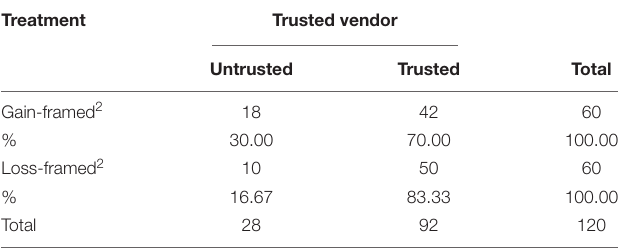
TABLE 6 | Decision 4 – choosing a trusted vendor by treatment 1 .